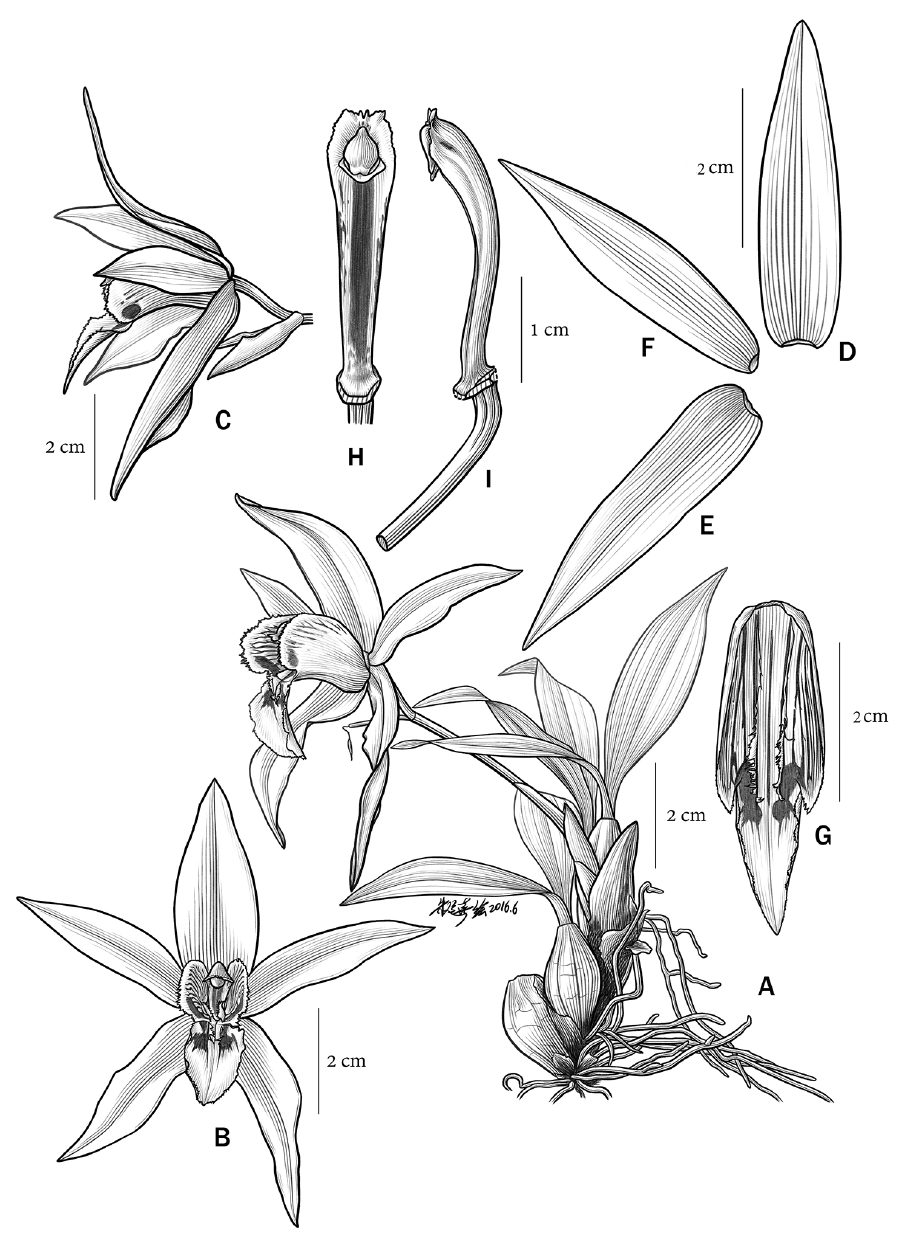
Figure 1. Coelogyne magnifica Y.H. Tan, S.S. Zhou & B. Yang sp. nov. A Habit B Flower (front view) C Flower (side view) D Dorsal sepal E Lateral sepal F Petal G Lip H Column (frontal view) I Column (lateral view). Illustration by Yunxi